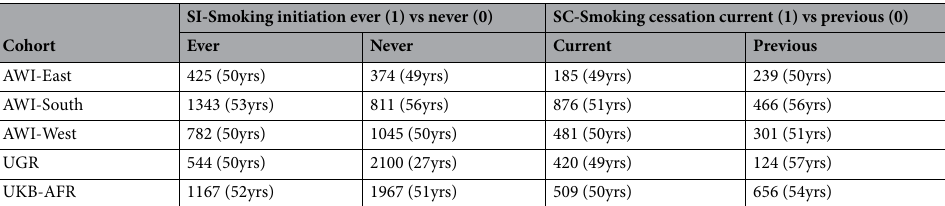
Table 1. Sample size (and mean age) for each phenotype in each dataset for cases (1) and controls (0). AWI Africa Wits-INDEPTH Partnership for Genomic Studies, UGR Uganda Genome Resource, UKB-AFR individuals of African ancestry in UK Biobank, yrs